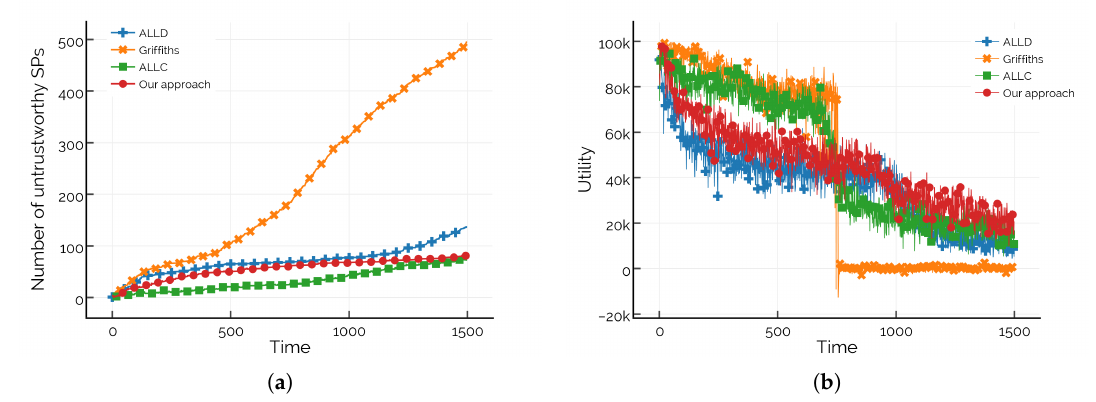
Figure 6. ( a ) Number of untrustworthy service providers; ( b ) Utility obtained at different time